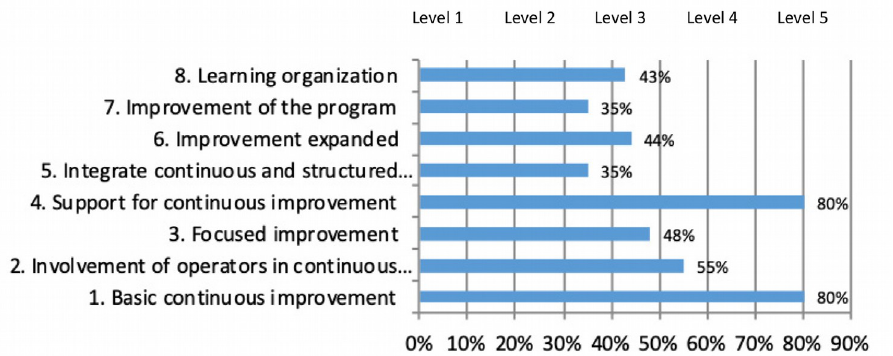
Figure 3. Maturity level in C1